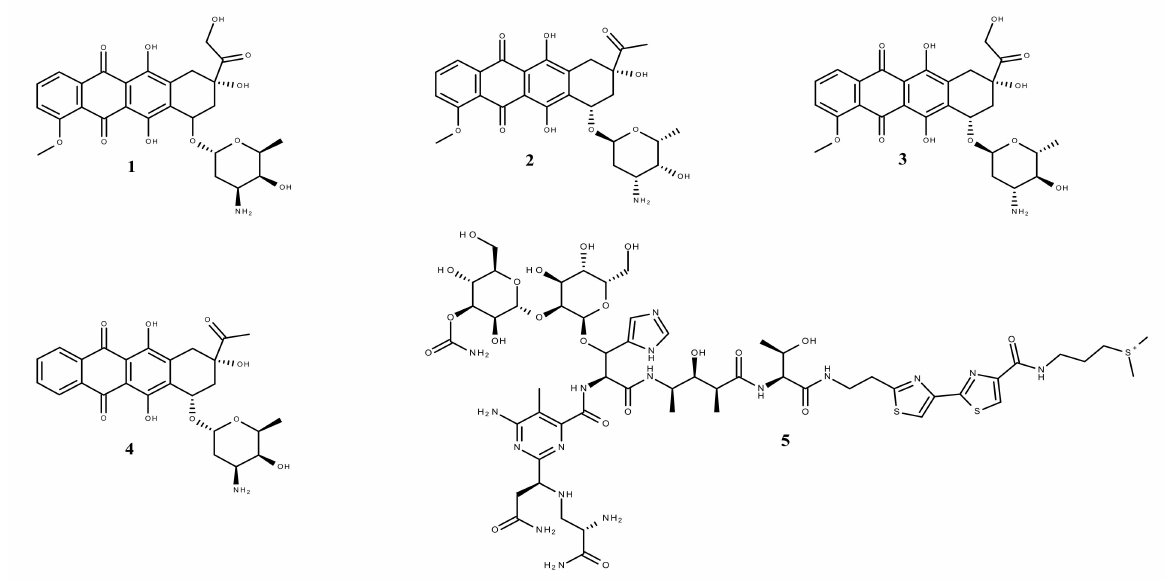
Figure 1. Chemical structures of (1) doxorubicin, (2) daunorubicin, (3) epirubicin, (4) idarubicin and (5) bleomycin.